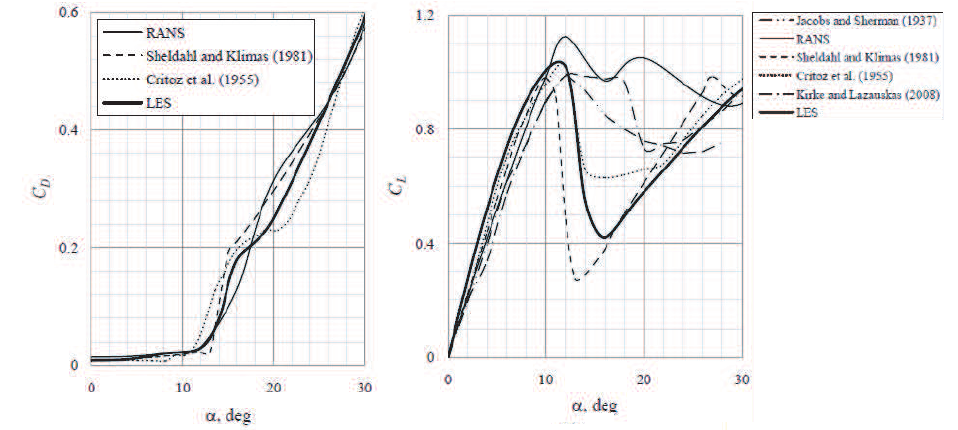
Figure 18. Lift ( left ) and drag ( right ) as a function of AOA at Re = 3.6 × 10 5